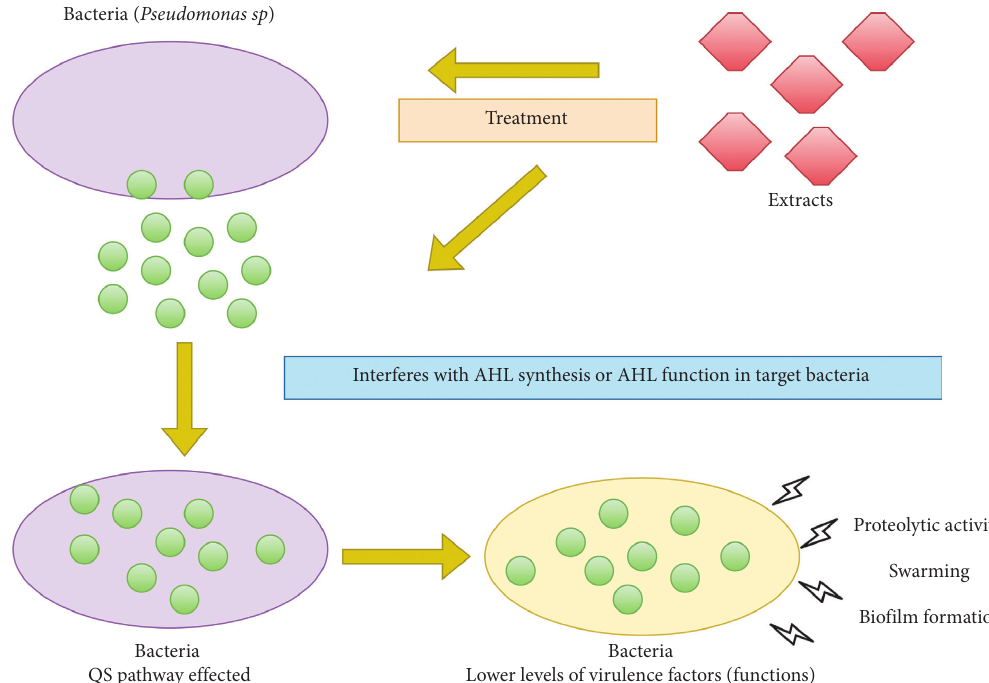
Figure 2: Representation of quorum sensing, modulates the pathogenic virulence on